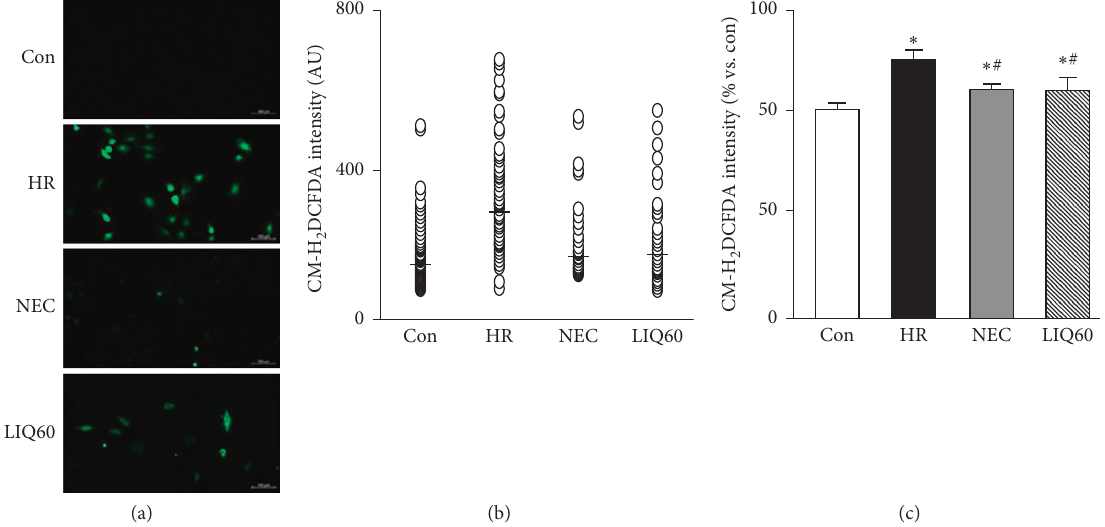
Figure 5: Mitochondrial oxidative stress in H9C2 cells subjected to different treatments. (a) Representative images of H9C2 cells stained with 5-(and-6)-chloromethyl-2 ′ ,7 ′ -dichlorodihydrofluorescein diacetate, acetyl ester (CM-H ₂ DCFDA). (b) The graph indicates fluores- cence intensity per cell ( ○ , open circle) of the representative images. (c) The graph indicates the total CM-H 2 DCFDA intensity; AU: arbitrary unit; Con: normal control; HR: hypoxia/reoxygenation; NEC: HR+NecroX-5; LIQ60: HR +LIQ at a dose of 60 μ M; ∗ p < 0 . 05 vs. Con; # p < 0 . 05 vs. HR; n � 3 ÷ 5; scale bar 100 μ